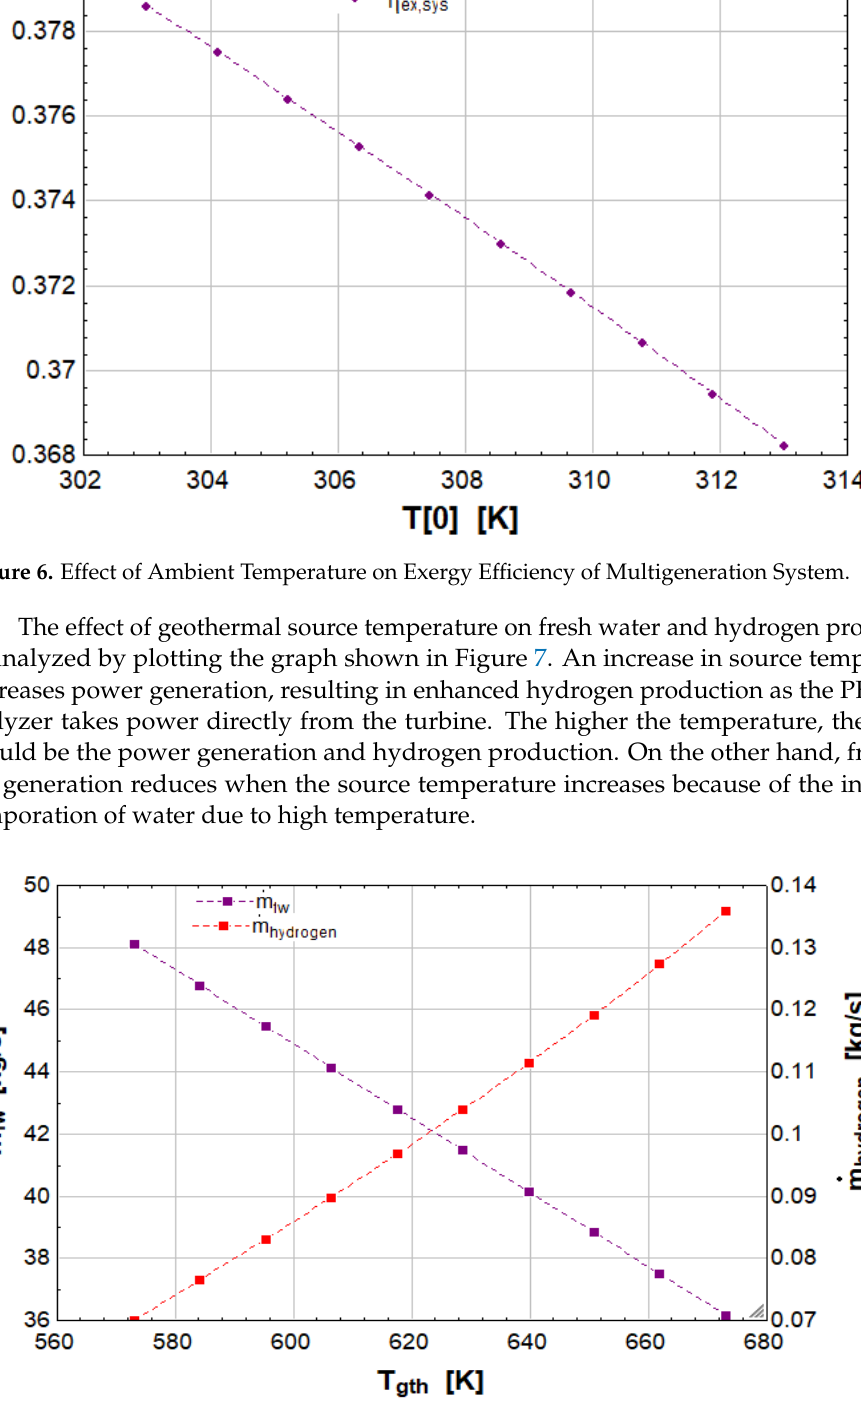
Figure 7. Effect of Geothermal Source Temperature on Fresh Water and Hydrogen Production .